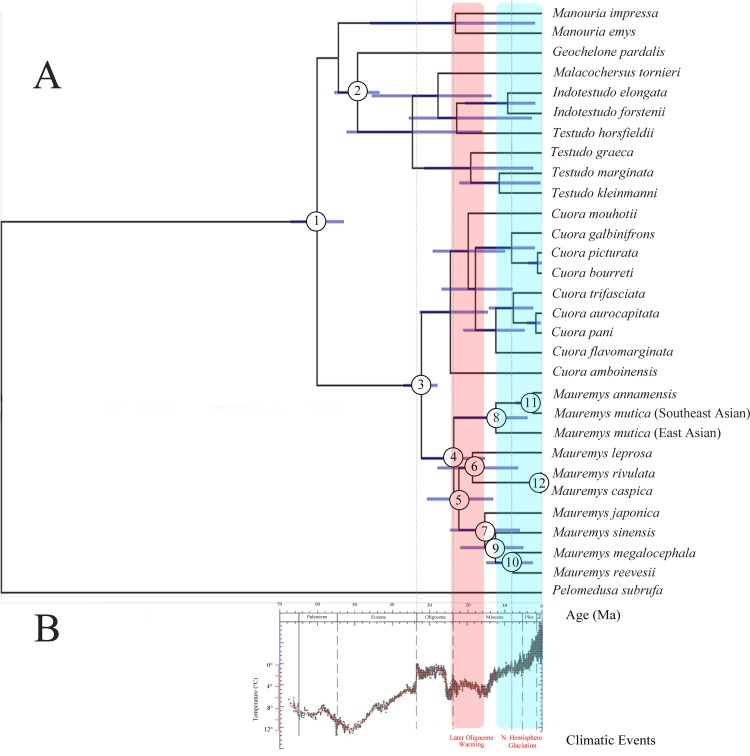
Chronogram using BEAST 1.8.0 based on mt heavy chain 12 protein-coding genes.A. Divergence time estimation; B. The trend of temperature change redrawn from Zachos et al.’s results [27]. The red zone represents the warming period. The blue zone represents the glacial period.